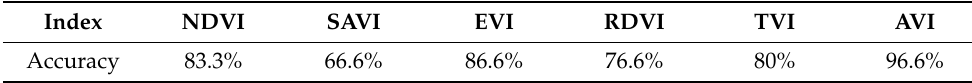
Table 1. Accuracy assessment of all the used vegetation indices.